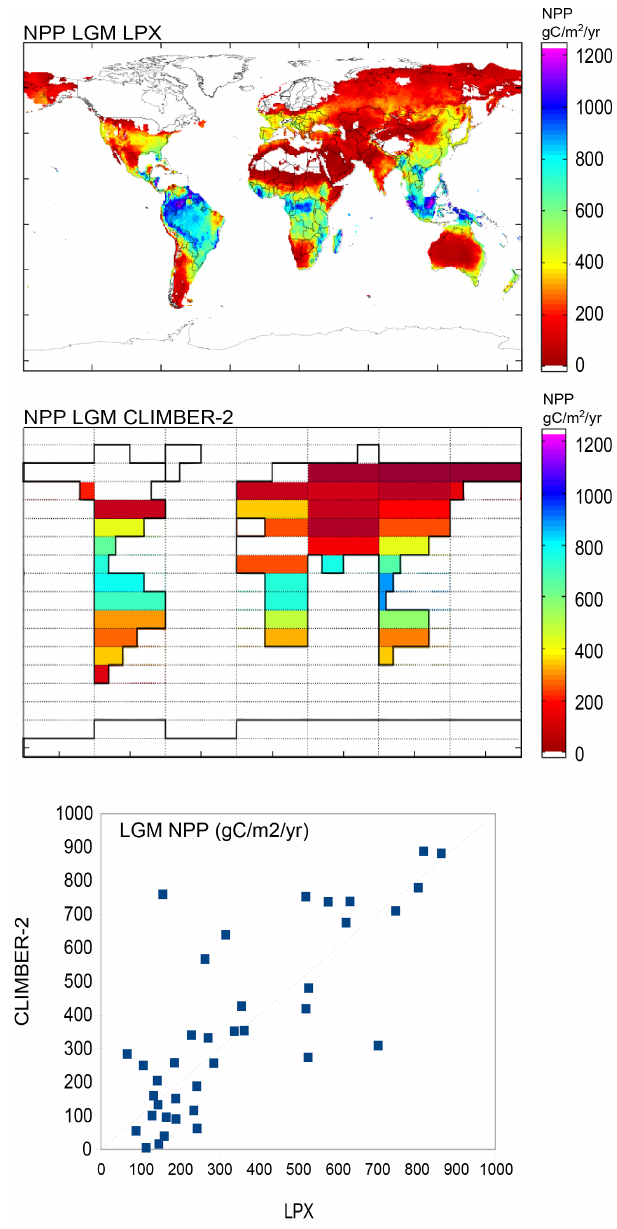
Figure 5. Comparison of NPP, which has a control on carbon in- put to soils, for LPX model (top, courtesy of M. Martin-Calvo, av- erage of an ensemble model output) and CLIMBER-2 model for LGM(eq) (at 21kyr BP) plotted on the same scale (gCm − 2 yr − 1 ), and the same scale as Fig. 4. LPX output upscaled to CLIMBER-2 grid and plotted against equivalent CLIMBER-2 NPP is shown also.